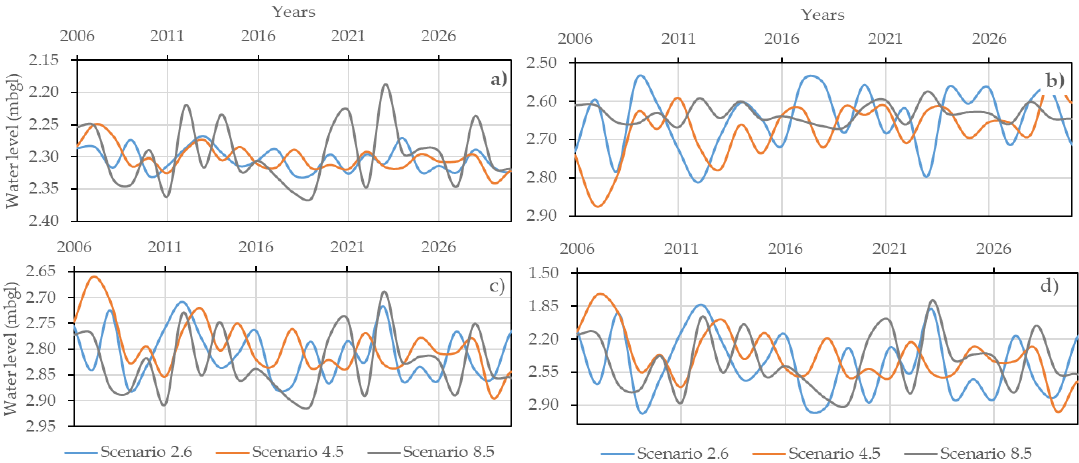
Figure 11. Water level projection with respect to the RCPs for the observation wells ( a ) STW1, ( b ) STW2, ( c ) STW3, and ( d ) DTW1.